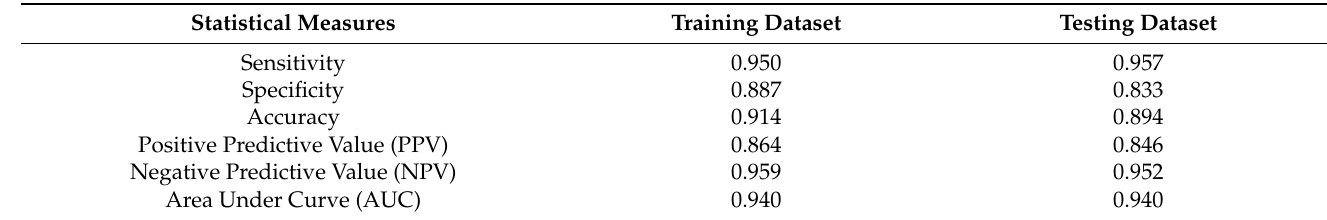
Table 1. Results of model validation for training and testing